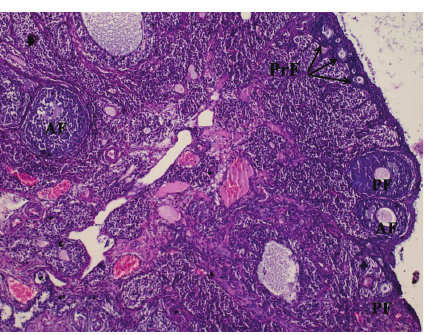
Figure 2: Ovarian tissue sample where all stages of follicular development containing primordial follicles (PrF-arrows), primary follicle (PF), and antral follicle (AF) are clearly seen in the left ovary sample (H&E ×